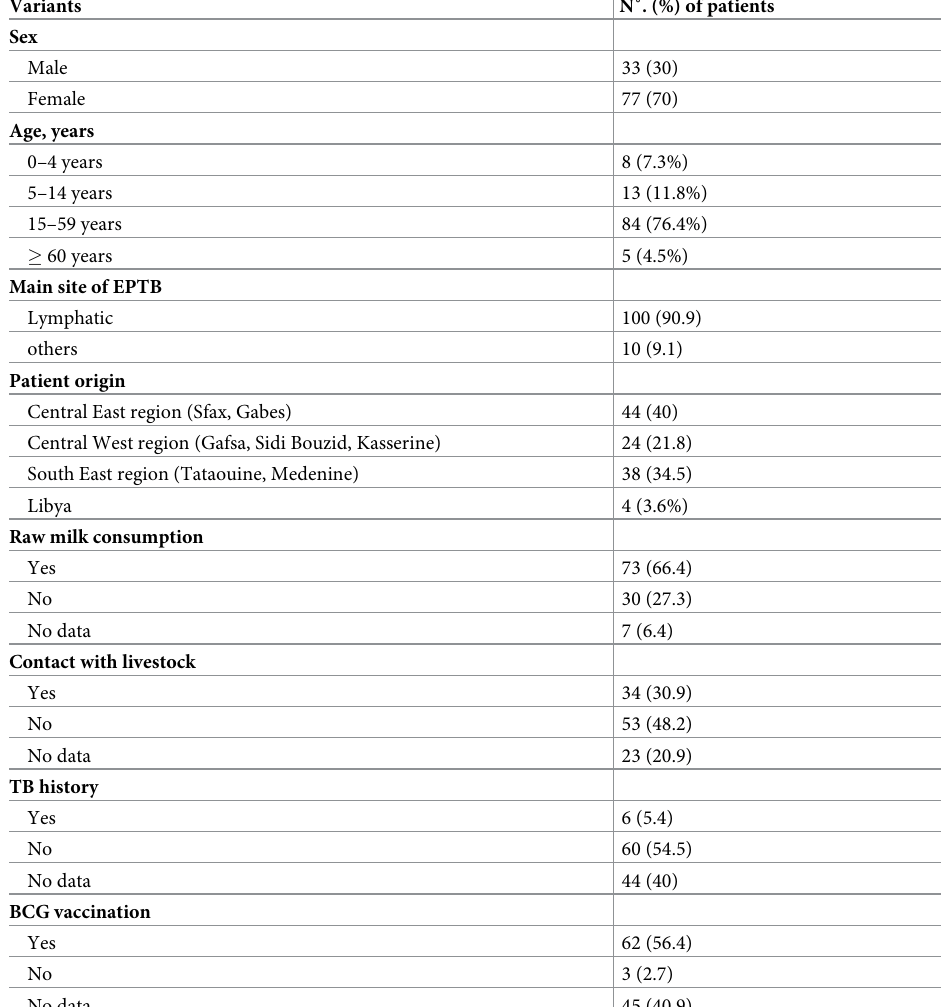
Table 1. Demographic and clinical characteristics of the 106 Tunisian extrapulmonary tuberculosis patients and the 4 isolates from Libyan